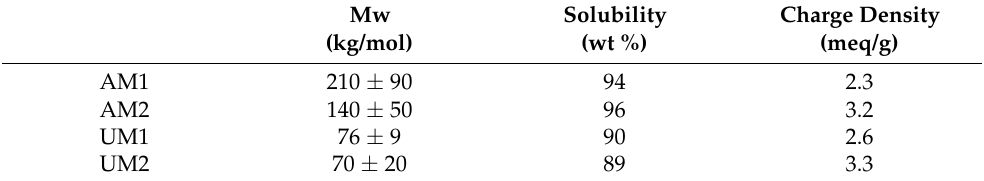
Table 3. Lignin–METAC polymer molecular weight, solubility, charge density, and grafting